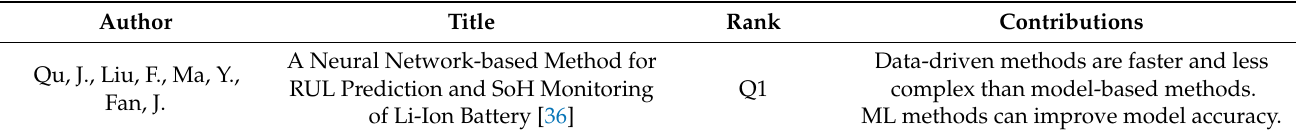
Figure 4. Keyword co-occurrence in the literature review. Table 4. List of most important papers and their specific